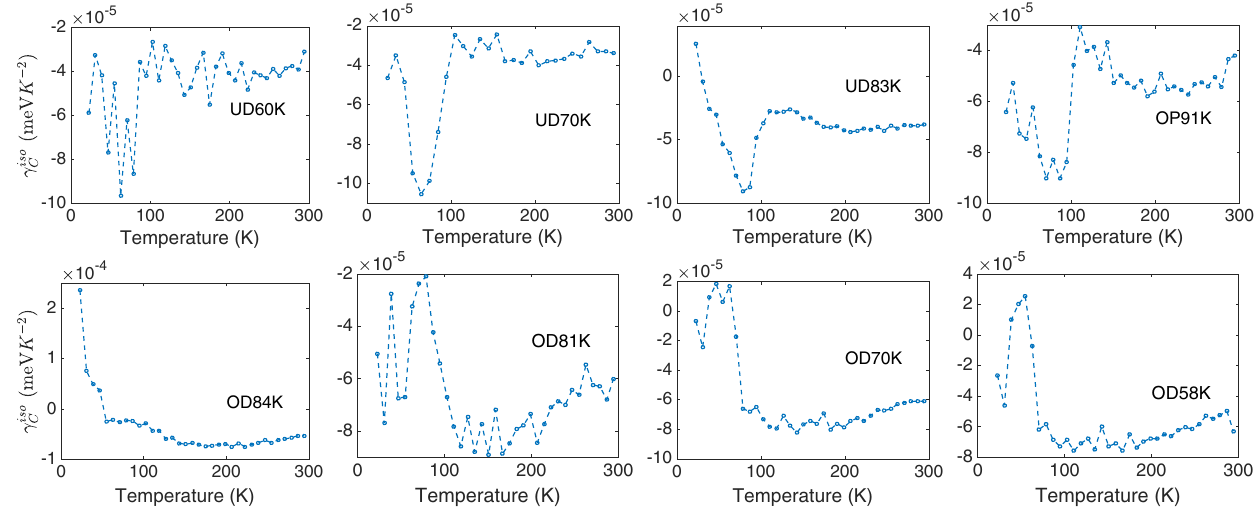
FIG. 4. Temperature dependence of γ iso